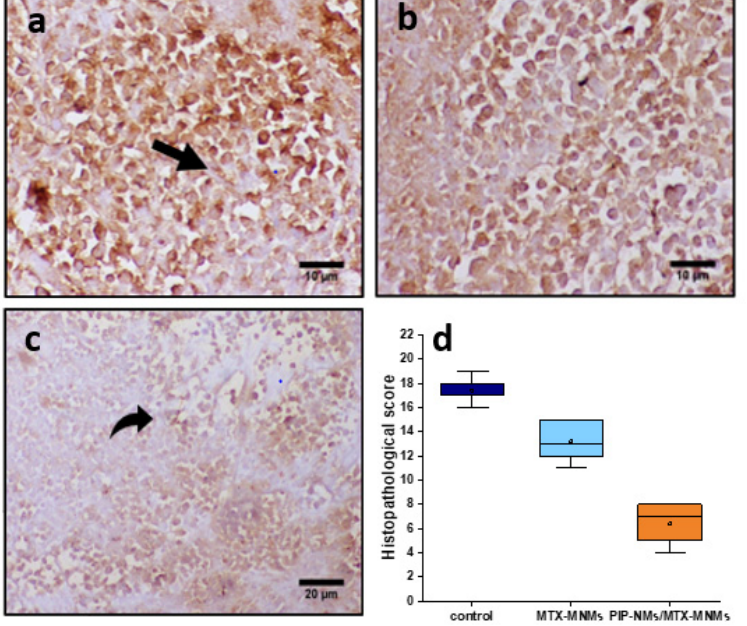
Figure 12. Immunohistochemical staining of TGF- β for ( a ) the control group, ( b ) MTX-MNMs-treated group, ( c ) PIP-NMs/MTX-MNMs-treated group, and ( d ) the area (%) of TGF- β . Straight and curved arrows are pointing to positive expression, and weak expression, re- spectively.